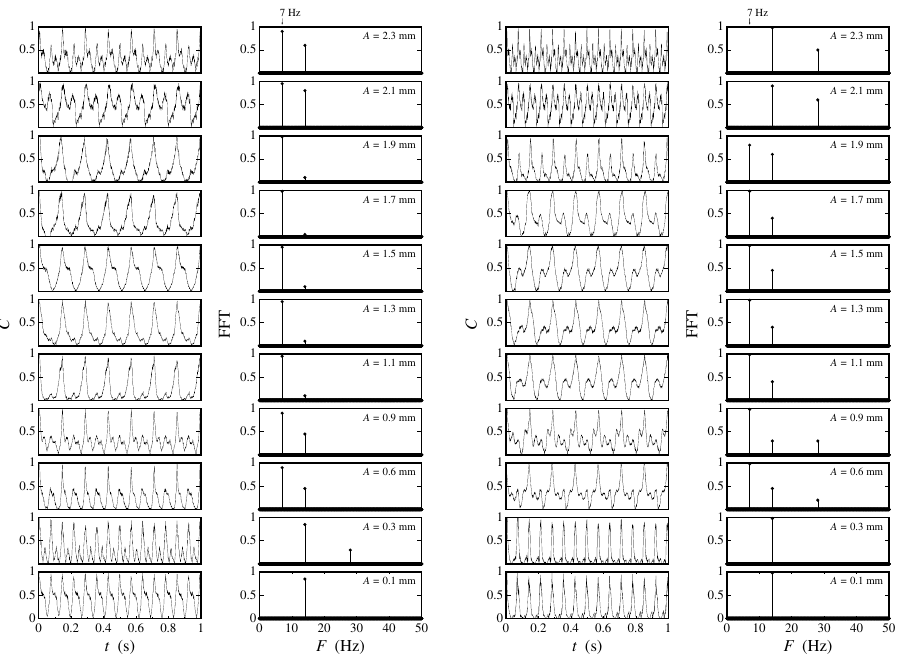
Figure 7. Pearson correlation coefficients as a function of time and corresponding frequency spectrum for F = 14 Hz and varying amplitudes from 0.1 mm to 2.3 mm. The two columns of plots on the left are for the small ( l = 2.5 cm) cells, while the two columns of plots on the right are for the larger ( l = 5 cm) cells.